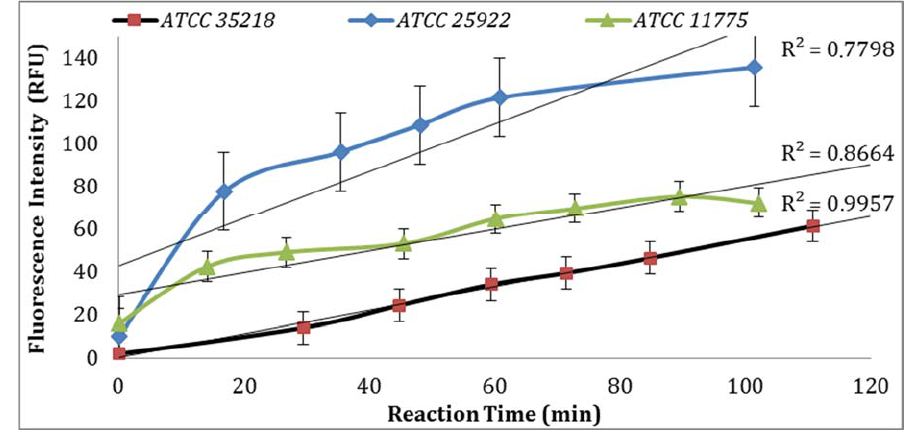
Figure 1. Time series of hydrolysis of MUG by different strains of E. coli (100 CFU/mL).